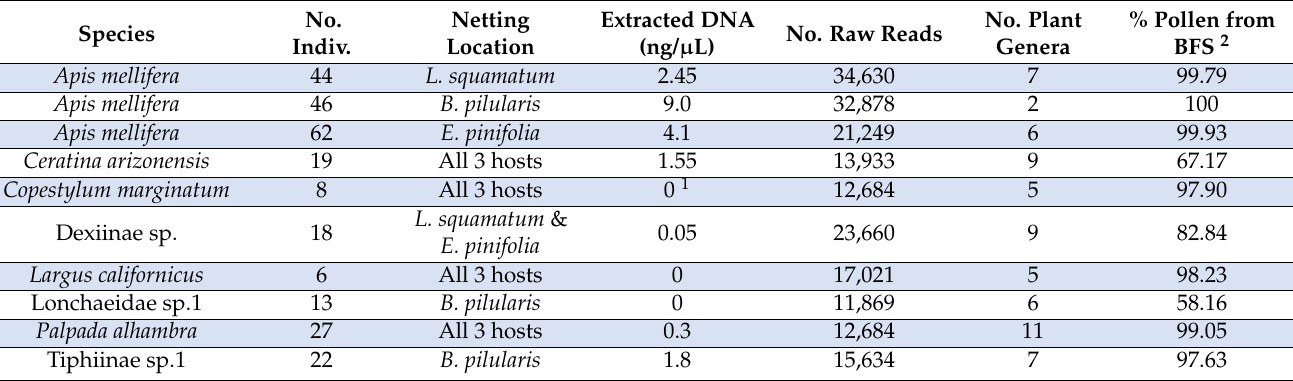
Table 2. Species selected for pollen removal and molecular analysis and results of pollen DNA analysis. Concentration of extracted DNA was recorded using a EZDrop™ 1000. While no DNA was detected in some samples, sequencing was nonetheless successful. % Pollen from BFS was calculated by adding the relative abundance of all sequences from genera found at the